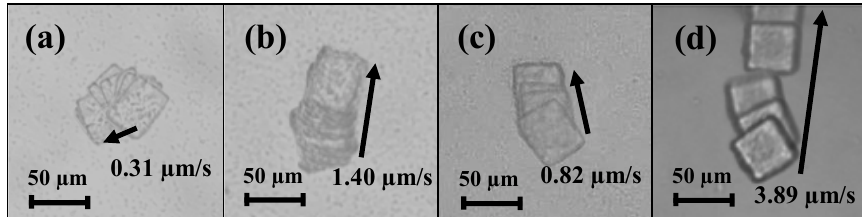
Figure 5. Images of individual video frames of movement of bacteria-tethered cubic microstructures captured by microscope. ( a ) Untreated control microstructure. ( b ) Microstructure coated on five-sides by BSA. ( c ) X-ray irradiation treated microstructure. ( d ) Microstructure treated on one side by